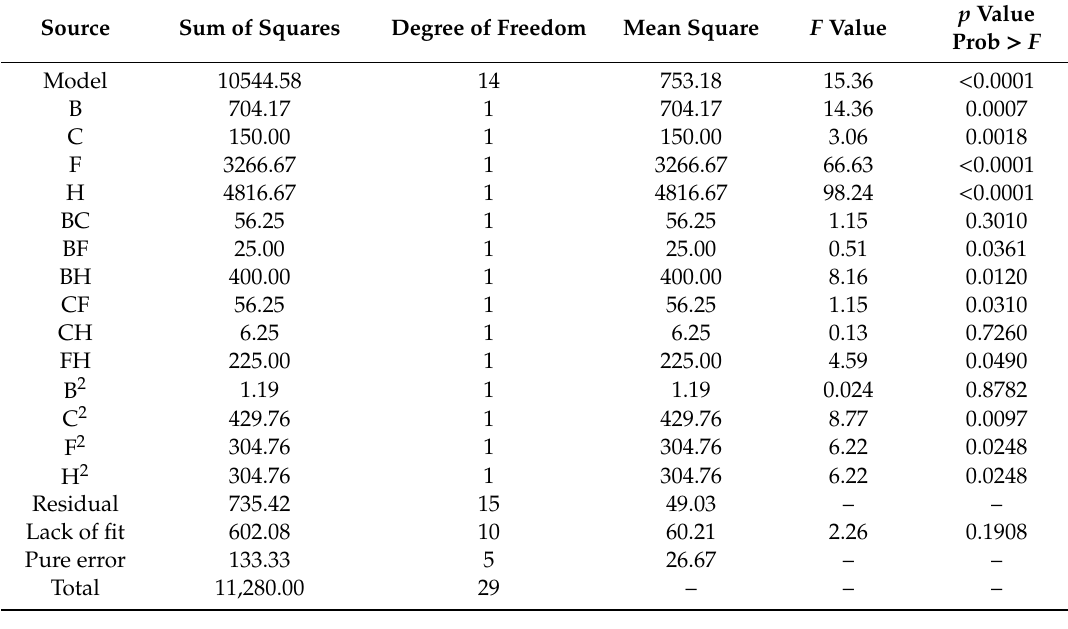
Table 5. Analysis of variance for the response surface of the quadratic polynomial model.